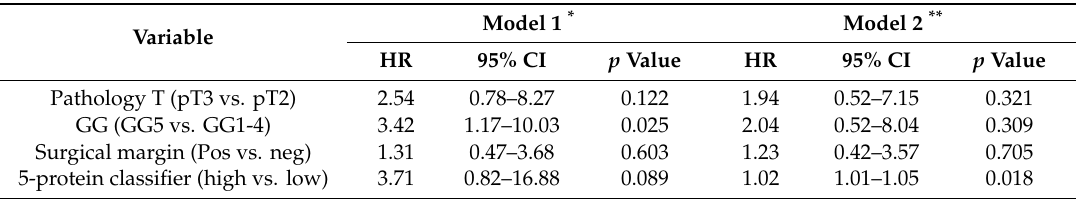
Table 6. Multivariable Cox proportional hazard model predicting DM as a function of a 5-protein classifier to complement pathology SOC variables in study testing